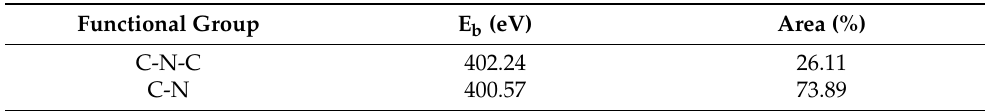
Table 4. The surface functional group content of nitrogen element (N) of water-insoluble gardenia blue